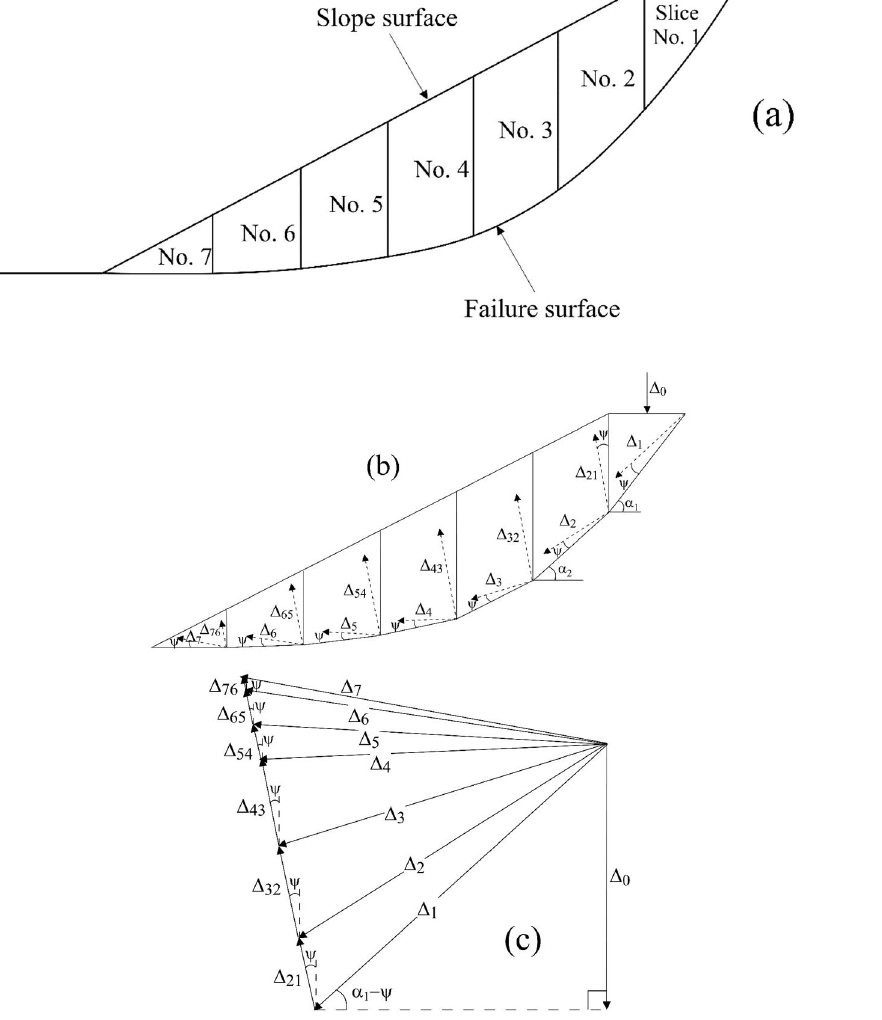
Figure 8. ( a ) Example of sliced potential failure mass; ( b ) Vector of displacements along failure surface and inter-slice faces for Ψ > 0 and ( c ) Hodogram for Ψ >